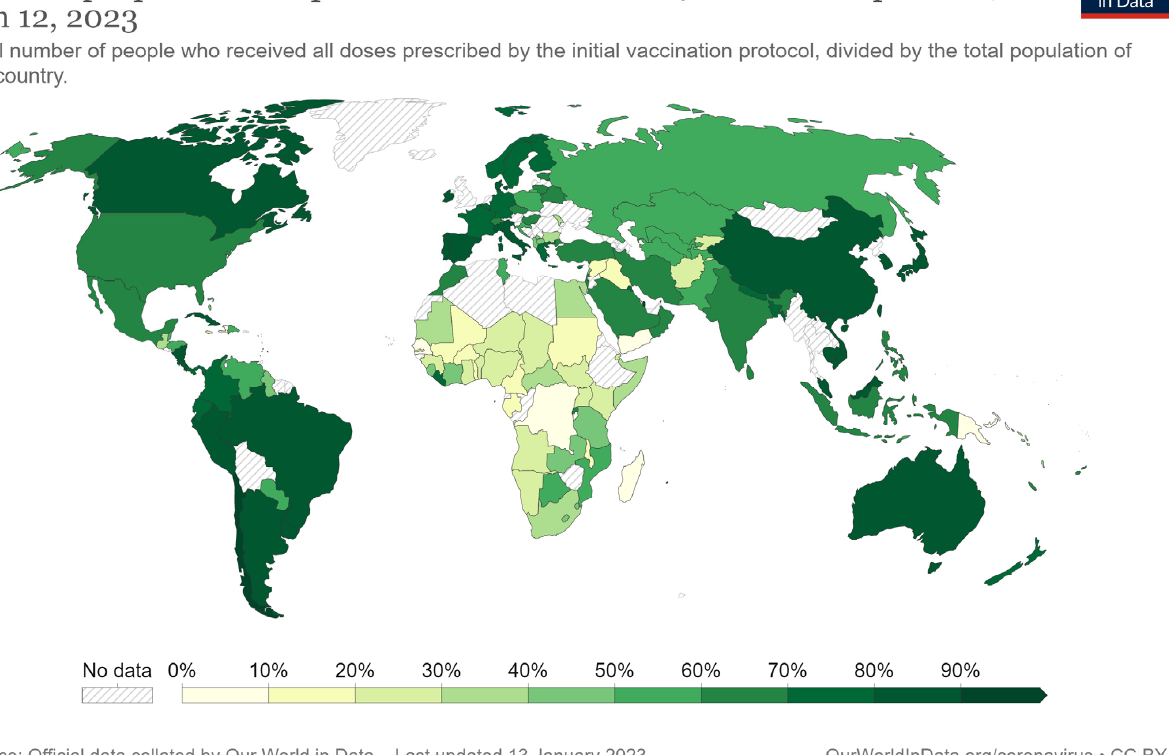
Figure 1. Percentages of people who have completed the vaccination protocol [28].